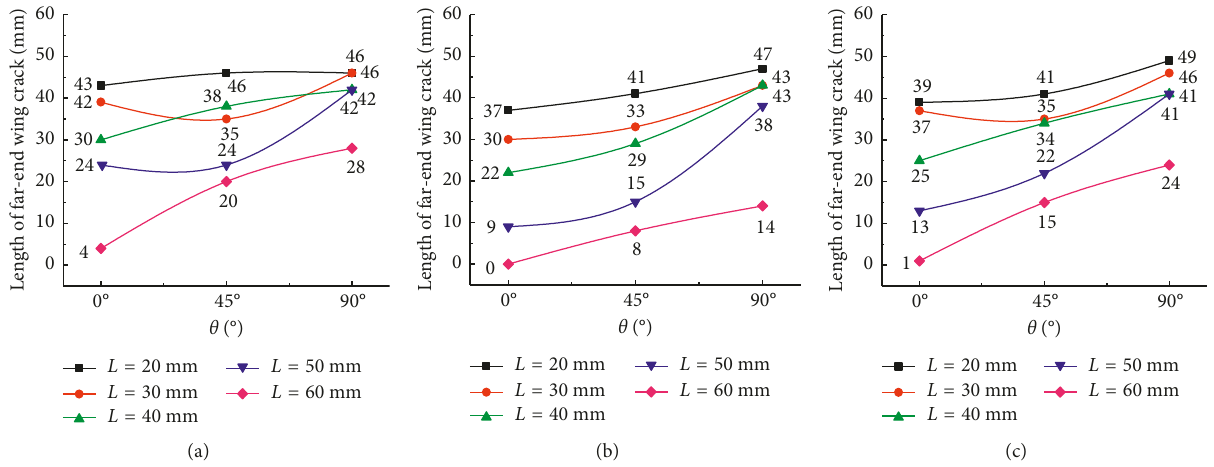
Figure 22: Relationship between θ and length of the far-end wing crack. (a) Air; (b) soil; (c) water.